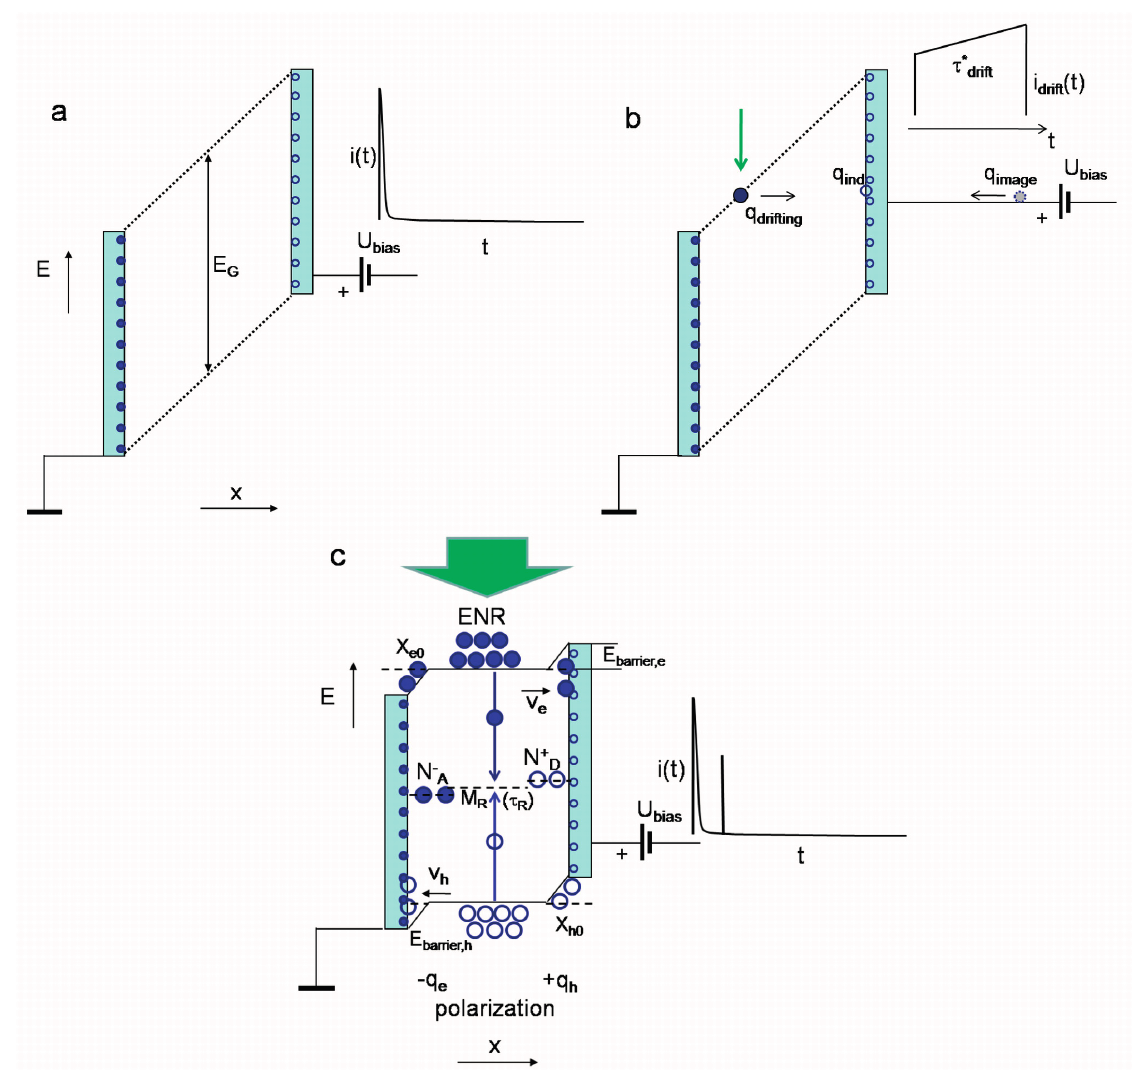
Figure 3. Sketches of the changes of the induced charges and of energy band diagram ( E ) within a capacitor structure filled with diamond (of band-gap E G ). ( a ) Charges (small circles: hollow -positive, solid- negative charges) induced on electrodes just after switching-on of the DC external voltage. On the right, a current transient of charging of the capacitor sensor is sketched; ( b ) Sketch of the monopolar drift phase for the light injected charge (large circle) and formation of drift current pulse (on the right). Here, the induced charge on electrode and external current (image charge) during drift are also sketched; ( c ) Sketch of the polarization charge ( − q e, q h ) formation under both the excess carrier trapping onto deep centres (quasi-stationary polarization) and formation of the ( X e0 , X h0 ) depletion (from one type of excess carriers) regions at electrodes (dynamic polarization) after drifting ( v e , v h ) excess carriers arrive to electrodes. In the electrically neutral region (ENR), recombination ( τ R ) through centres M R is possible, while charged centres ( N − A , N + D ) can appear due to carrier trapping. On the right, a current transient of charging (of a photo-capacitance effect) of the capacitor sensor is